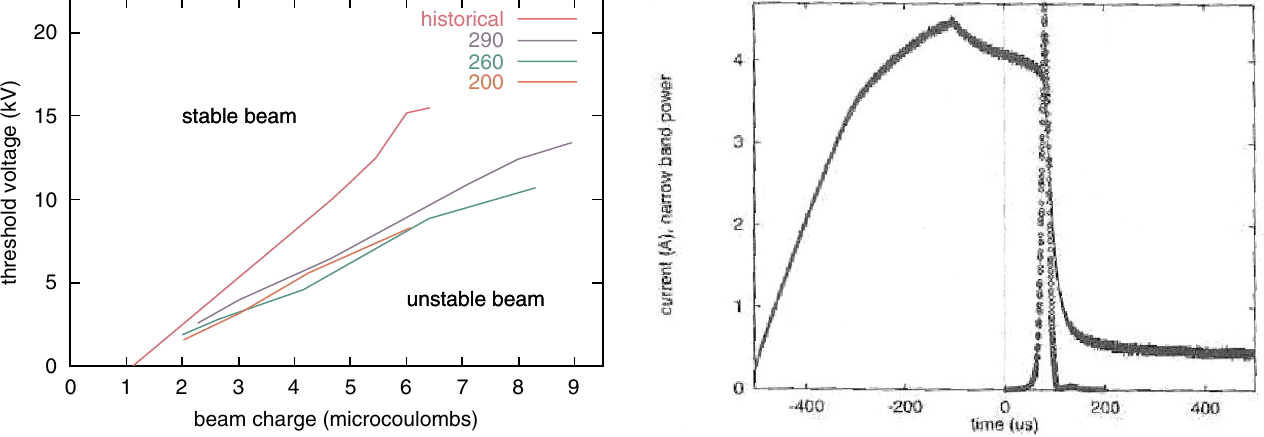
FIG. 11. Coasting-beam vertical instability at the BNL AGS booster in 1998/1999 [25]; shown are the beam current in units of A and the vertical narrow band power density at 76 MHz (smoothed over one turn); the horizontal span ranges from (cid:2) 500 to 500 (cid:7) s .